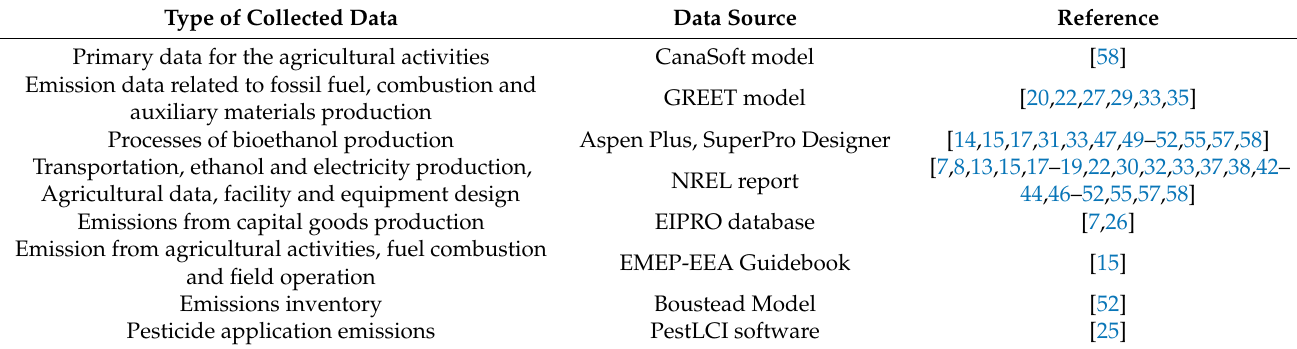
Table 2. Data sources used for life cycle inventory stage of the reviewed bioethanol LCAs.